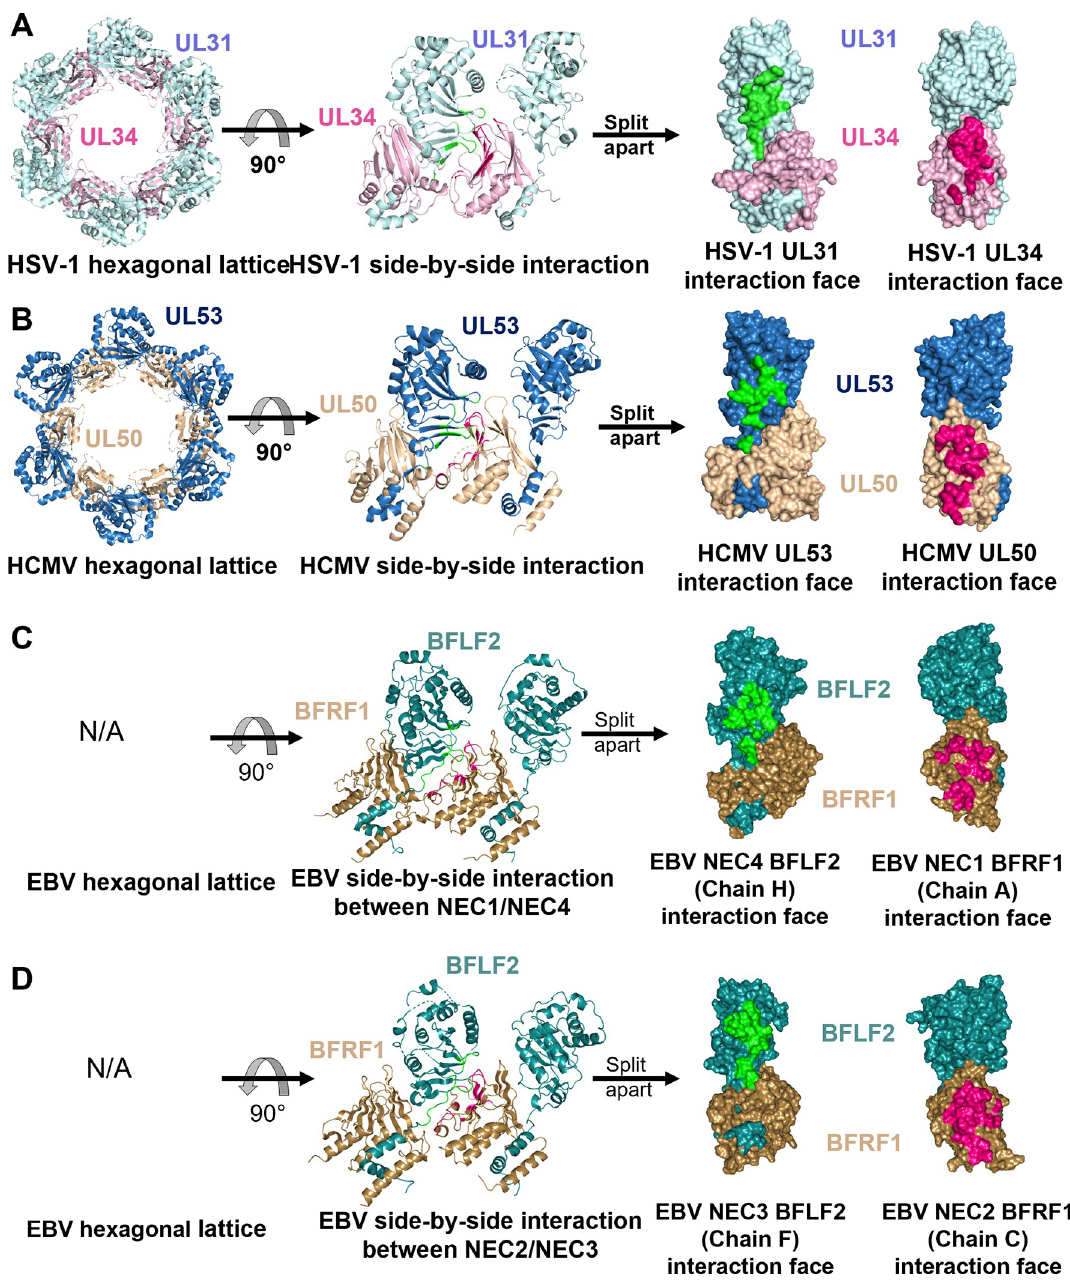
Fig 4. Oligomeric interfaces formed by HSV-1, HCMV, and EBV NEC homologs in crystals. Hexameric interfaces in crystals of HSV-1 NEC (rcsb pdb 4zxs) (A) and HCMV NEC (rcsb pdb 5d5n) (B), as well as dimeric interfaces in two EBV NEC heterodimer pairs (rcsb pdb 7t7i, this study) (C and D). Left column: NEC hexamers observed in the crystals of HSV-1 and HCMV are shown as top view. Center column: the NEC/NEC interfaces in HSV-1 and HCMV and EBV homologs are shown as side view. Right column: the same NEC/NEC interfaces are split, rotated towards the viewer, and shown in surface representation. HSV-1 UL31 (light blue), HSV-1 UL34 (pink), HCMV UL53 (blue), HCMV UL50 (beige), EBV BFLF2 (teal), EBV BFRF1 (brown). Interface residues were assigned by PDBePISA [46]. Only residues with 30% or more of their surface area buried at the oligomeric interface are shown, in green and mauve in UL31 and UL34 homologs, respectively.